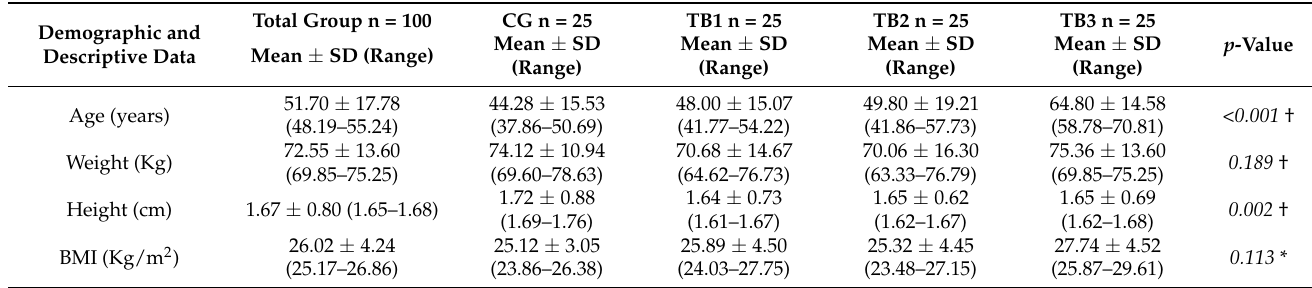
Table 3. Demographic and descriptive data of the sample population according to classification of tailor’s bunion. Demographic and Descriptive Data